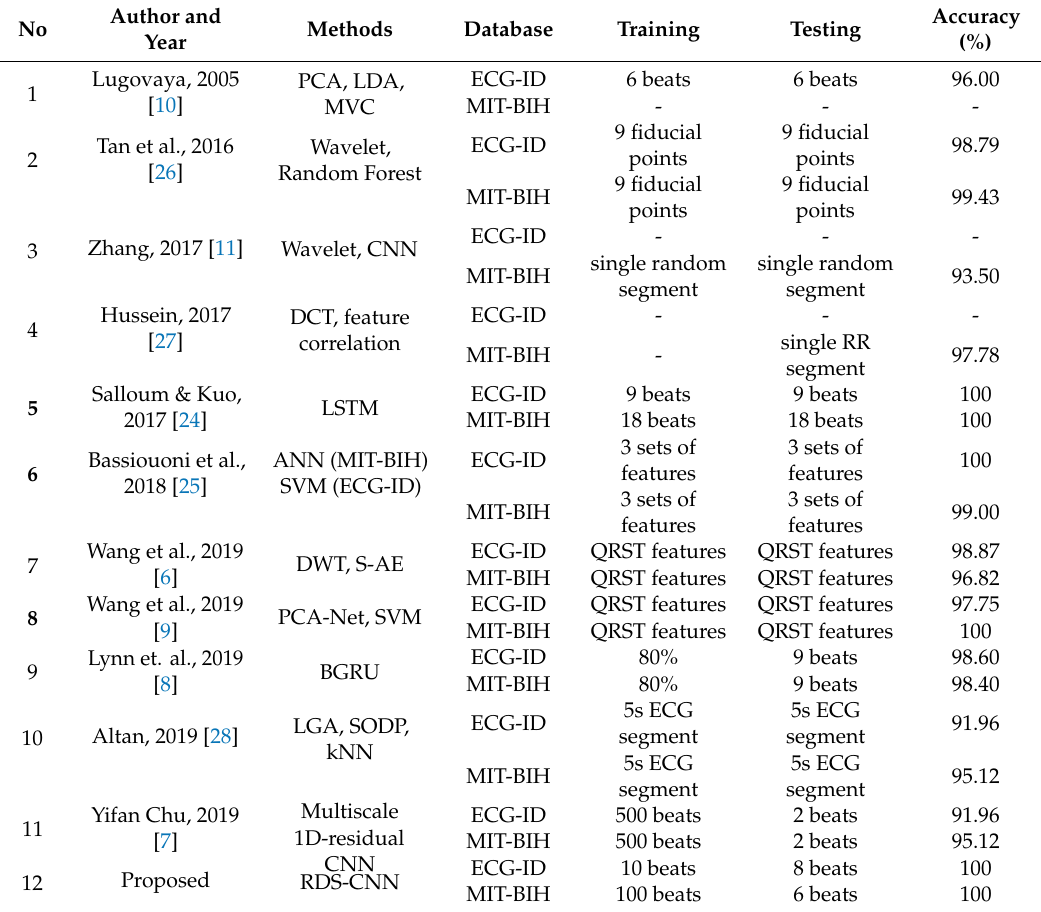
Table 6. Benchmarking of the proposed algorithm with other algorithms using ECG-ID and MIT-BIH